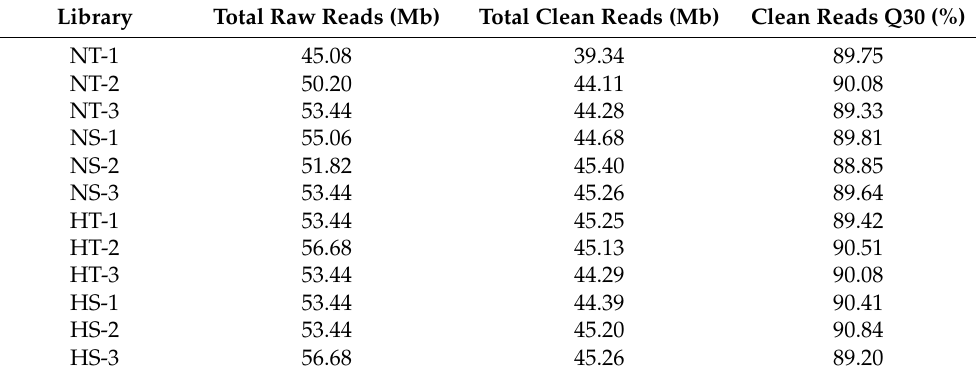
Table 1. Statistics of sequencing reads after filtering.